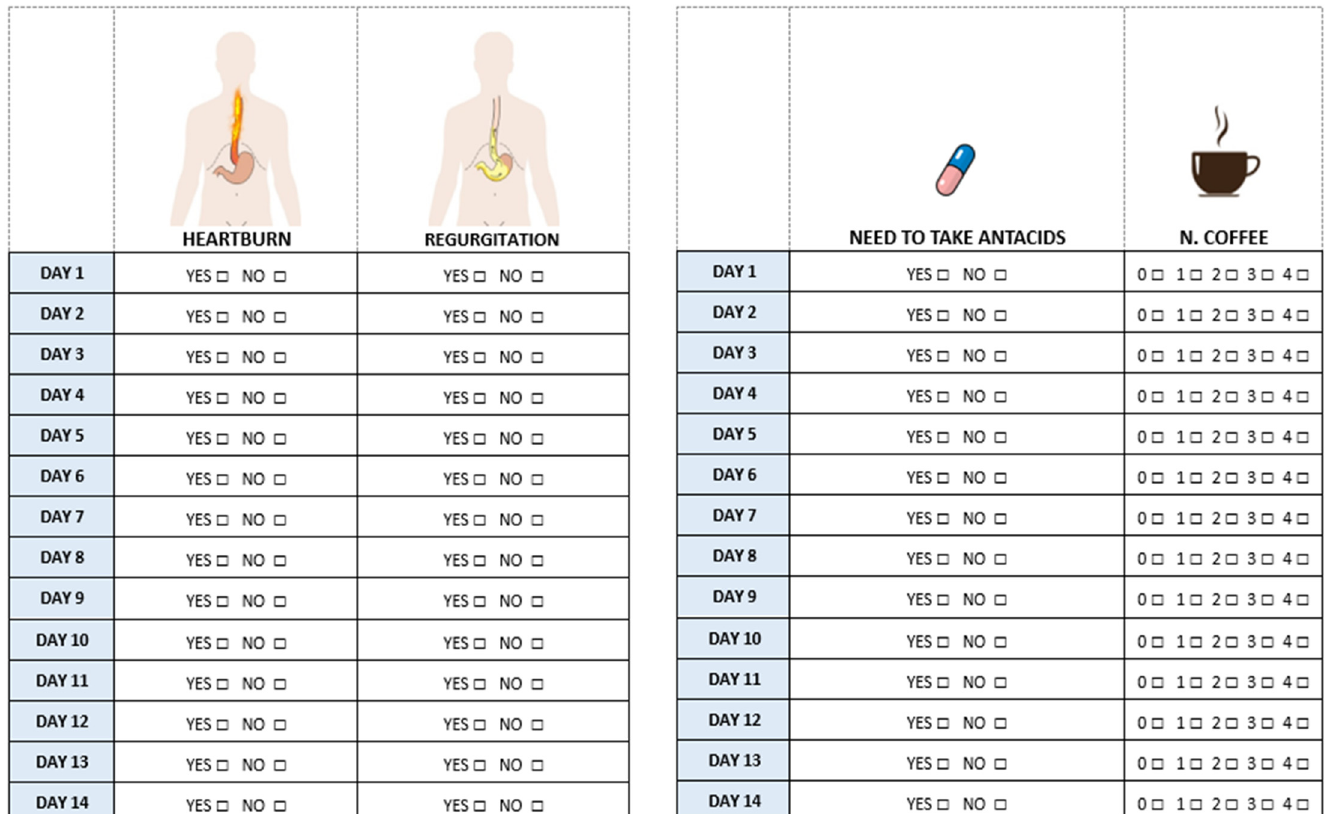
Figure A1. Patient diary during the 14 treatment days. Annotation for heartburn, regurgitation symptoms, and need to take antacids correlated to coffee intake.